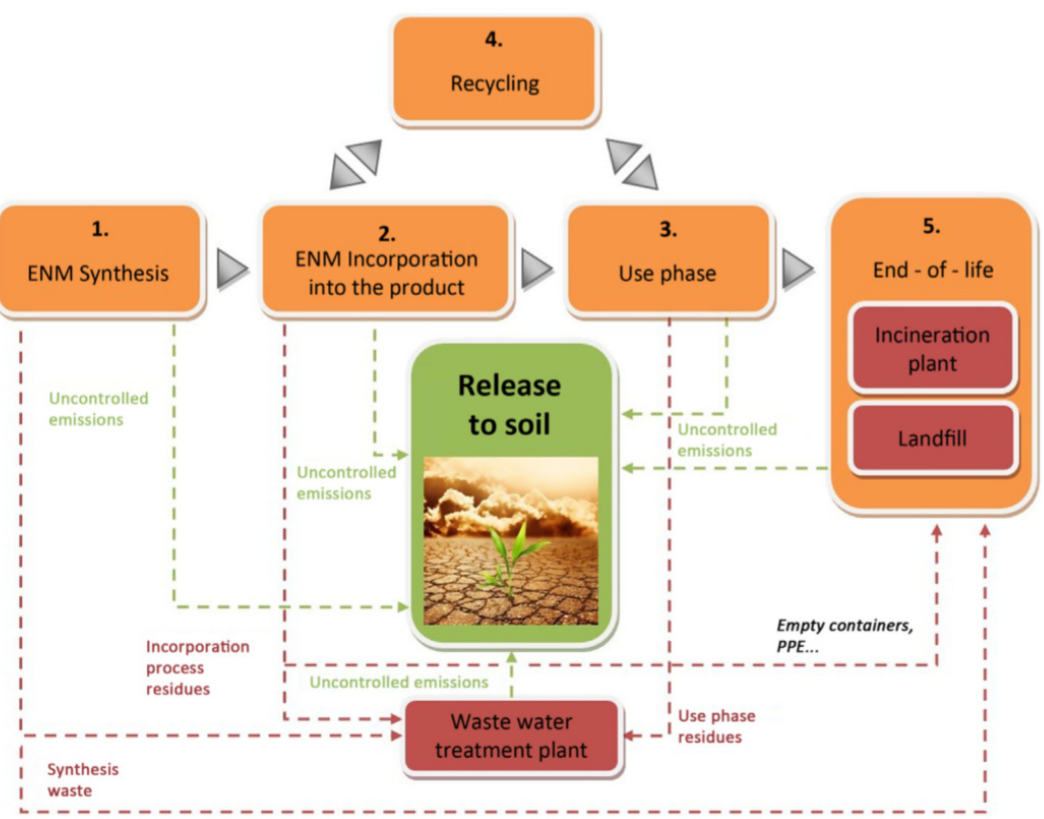
Figure 6. Overall life cycle path examination. Green arrows specify the discharges to the soil and red arrows designate the engineered nanomaterial (ENM) discharge paths ending up in end-of-life treatments or waste management, from which discharge to soil could also happen. Reproduced with permission from [124]. Elsevier, 2018. Nanomaterials 2020 , 10 , x FOR PEER REVIEW